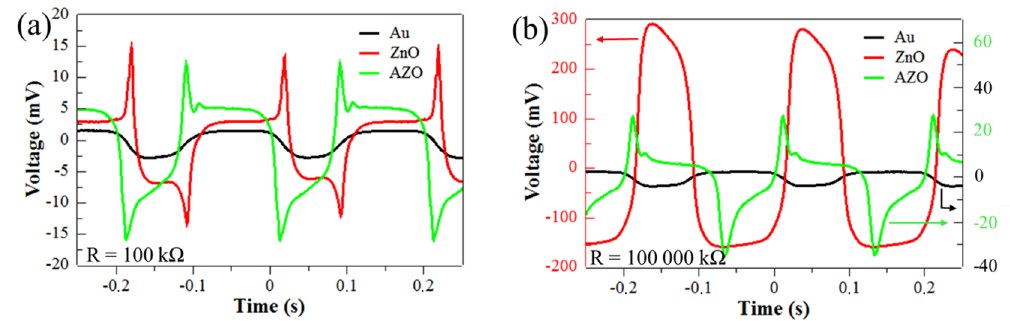
Figure 9. Output voltage response of PENGs based on Au, ZnO and AZO seed layers at a resistive load of ( a ) 100 k Ω and ( b ) 100,000 k Ω with a 3 N force applied at 5 Hz.